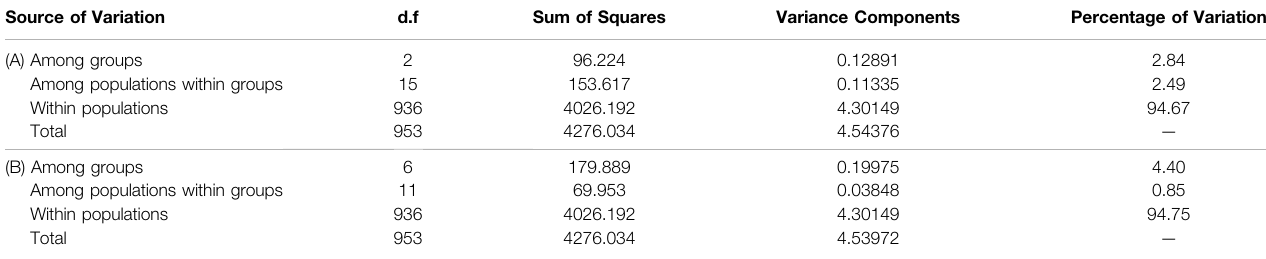
TABLE 5 | AMOVA for the 18 analysed populations of C. caespitosa considering (A) three or (B) seven groups. p values for all of the results in both analyses were signi fi cant ( p < 0.0001). Source of Variation d.f Sum of Squares Variance Components Percentage of